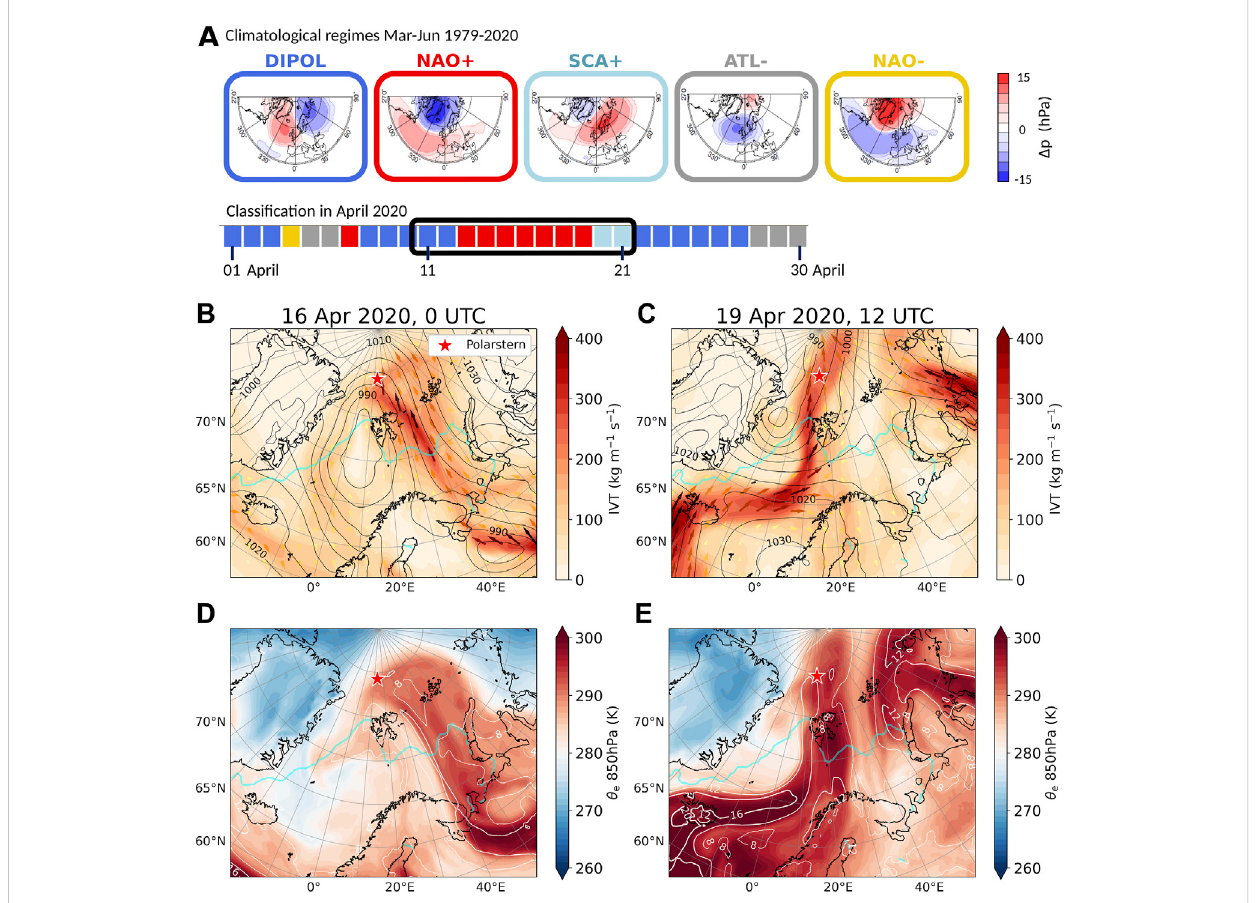
FIGURE 1 (A) Spring circulation regimes in ERA5 reanalysis. Upper panel: fi ve preferred circulation regime patterns during spring time (MAMJ) identi fi ed as dipole (DIPOL), positive and negative North Atlantic Oscillation (NAO+, NAO-), Scandinavian blocking (SCA+) and Atlantic low (ATL-). Lower panel: classi fi cationduringApril2020,with11 – 21April2020markedbyablackframe. (B – E) SynopticoverviewbasedonERA5centeredon16April2020,0UTC and 19 April 2020, 12 UTC. (B,C) IVT (color shading and arrows), sea level pressure (black isobars; hPa); (D,E) 850 hPa equivalent potential temperature θ e (colorshading),IWV(whiteisolines;kg m -2 ).IneachgraphtheredstarshowsthelocationsofRVPolarsternandthecyanlineindicatesthe sea-ice margin based on 15% sea-ice concentration from